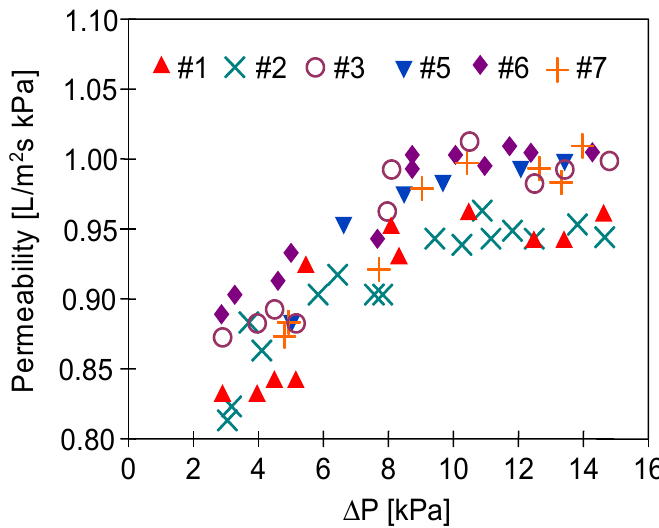
Figure 14. Permeability of membranes treated by plasma (after the MD process).